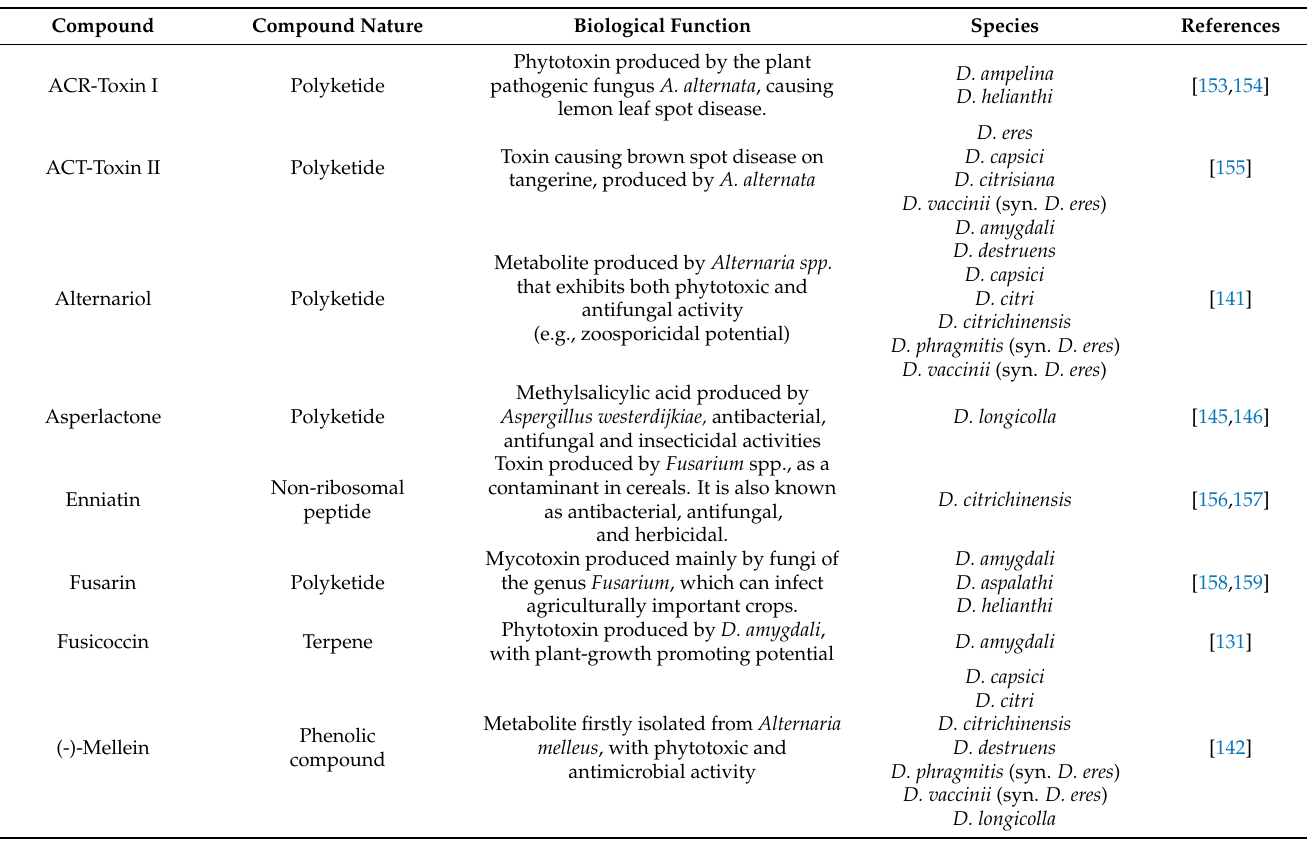
Table 4. Some secondary compounds produced by species of Diaporthe which are 100% identical to known